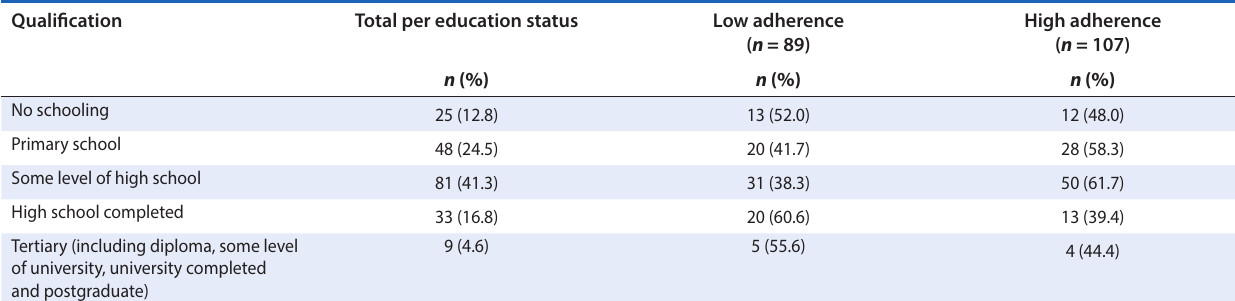
Notes: No statistical significance was found between the level of education and medication adherence ( χ 2 = 5.8, df = 4, p =